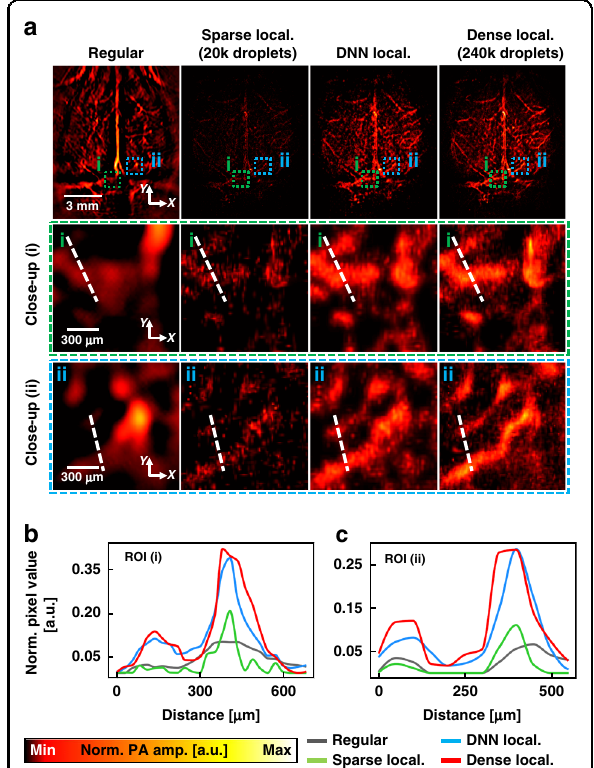
Fig. 4 Performance of 2D deep-learning localization PACT. a Regular, sparse localization, DNN localization, and dense localization PACT images of a mouse brain. Droplet counts of 240,000 and 20,000 are used for the dense and sparse localization- based images, respectively. Close-up views of the regions outlined by the i green and ii blue dashed boxes in a are displayed. Pro fi les of the PA amplitude indicated by the dashed lines in ( b ) i and ( c ) ii images, respectively. PACT photoacoustic computed tomography, PA photoacoustic, Sparse local. sparse localization-based PA image, DNN local. deep neural network localization-based PA image, Dense local. , dense localization-based PA image, ROI region of interest, Norm. PA amp. normalized PA